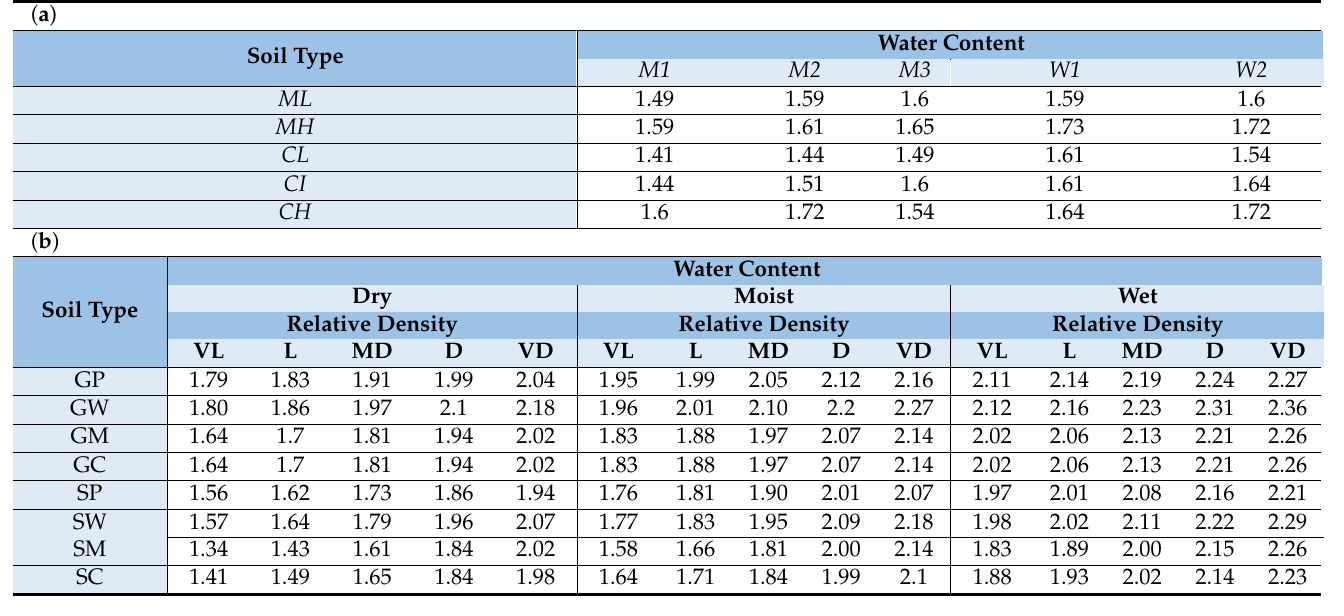
Table A1. Soil density estimated from detailed soil type and water content: ( a ) soil density for cohesive soils; ( b ) soil density for cohesionless